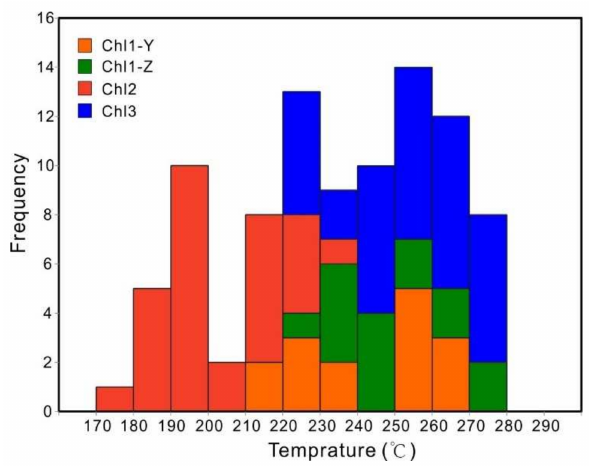
Figure 8. Histogram of the formation temperature range for the Zoujiashan and Yunji chlorite. Empirical geothermometric formula were from